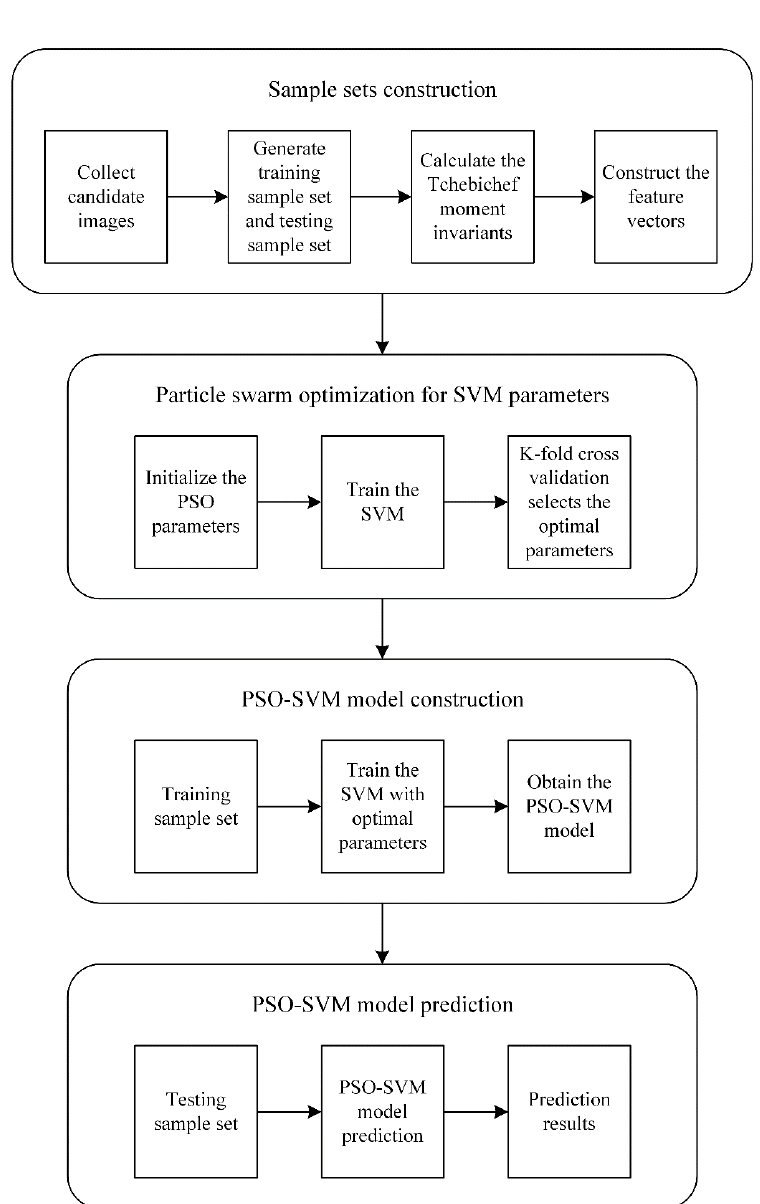
Figure 3. The flow diagram of fire image detection based on the PSO-SVM model.